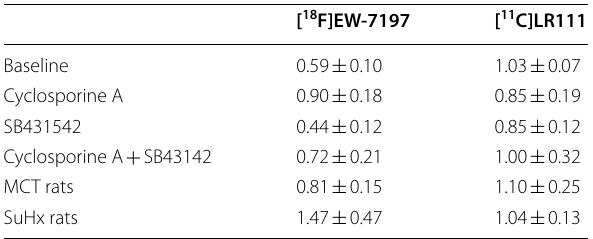
Table 3 Uptake in the lungs (expressed as SUV) of [ 18 F]EW-7197 and [ 11 C]LR111 assessed by PET at 15 min